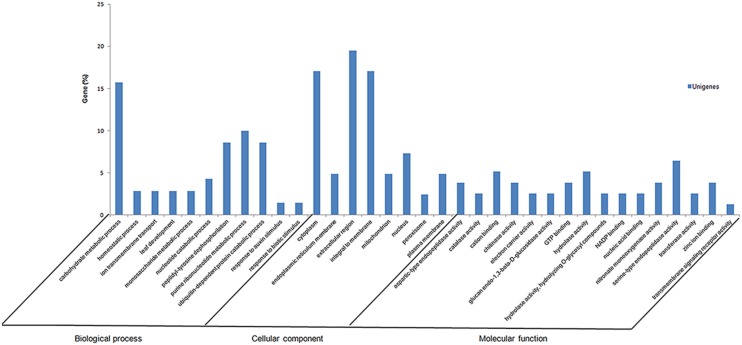
Summary of Gene Ontology annotation as assigned by Blast2GO. Functional annotation of the expressed sequence tags (ESTs) in Phaseolus vulgaris infected with Sclerotinia sclerotiorum SSH library using gene ontology terms (http://www.geneontology.org) by Blast2GO program. Most consensus sequences were grouped into major functional categories: biological process, cellular component, and molecular function.